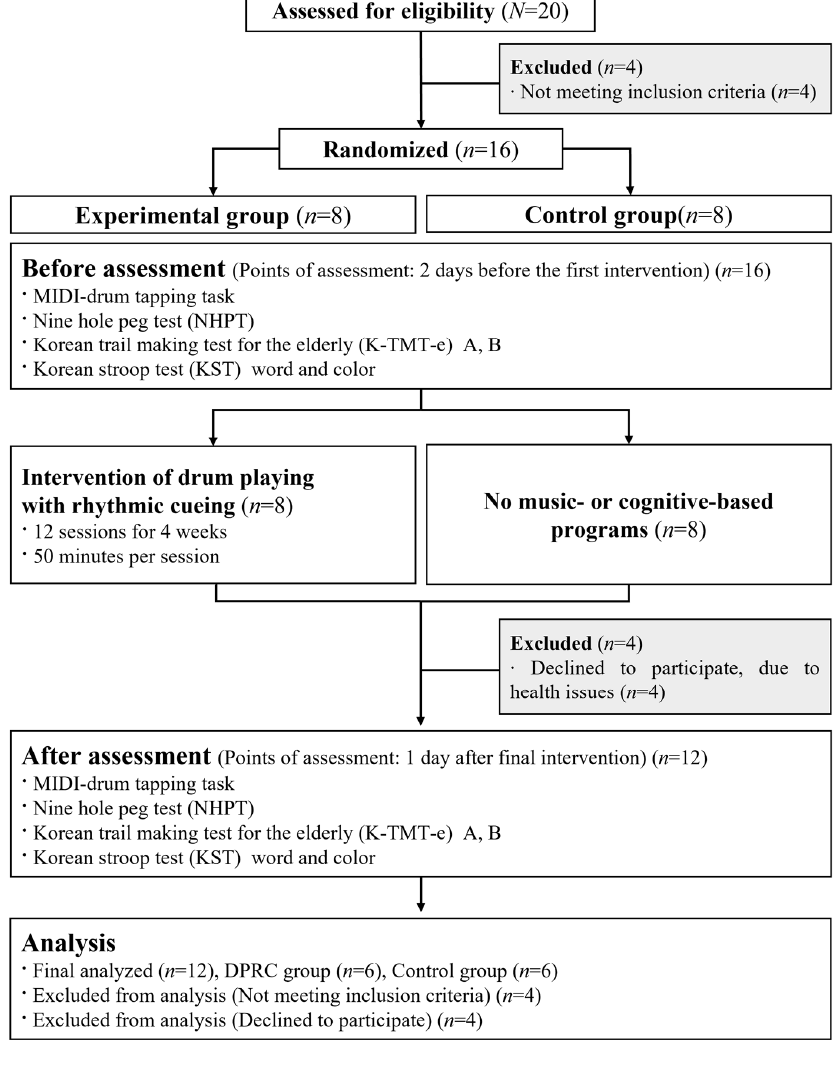
Figure 1. Flowchart for group allocation. Table 1. The MIDI drum tapping